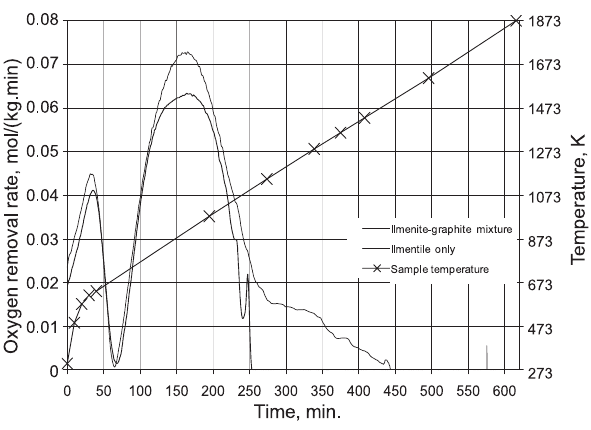
Fig. 2: H 2 O evolution during temperature programmed reduction of primary ilmenite concentrate in the H